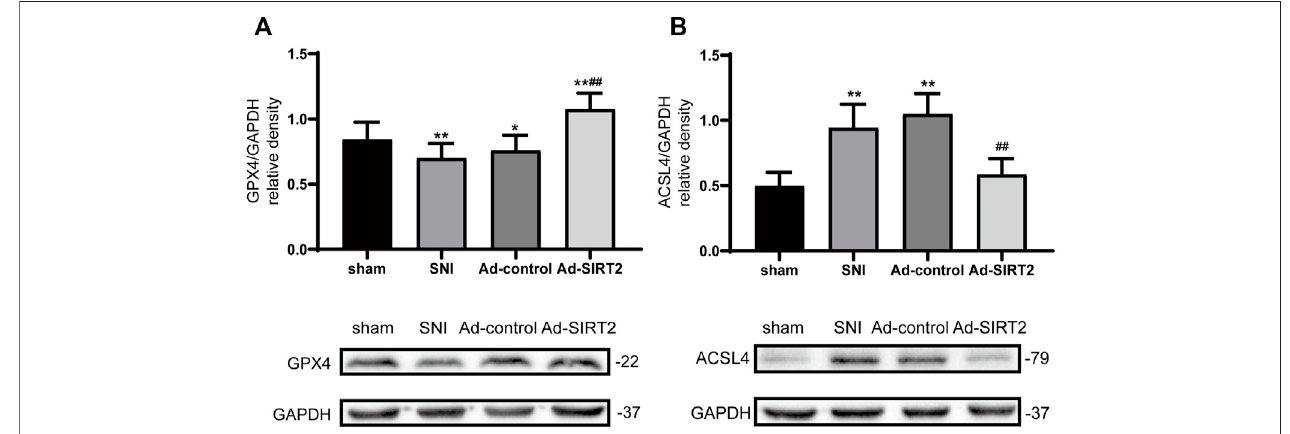
FIGURE6| IntrathecalinjectionofSIRT2increasedthelevelsofGPX4anddecreasedthelevelsofACSL4. (A) ChangestoGPX4expressioninthespinalcordafter anintrathecalinjectionofAd-SIRT2orAd-control. (B) ChangestoACSL4expressioninthespinalcordafteranintrathecalinjectionofAd-SIRT2orAd-control.Theratsin theshamoperationgroupwereusedascontrols.Valuesareexpressedasmean±SE( n =5foreachgroup).* p -valuesof < 0.05and** p -valuesof < 0.01forcomparisons withshamratsorbaselinevaluesoftheSNIrats(day0);## p -valuesof < 0.01forcomparisonswithSNIorAd-controlrats.SNI,spared nerveinjury;SIRT2,sirtuin2; GPX4, glutathione peroxidase 4; ACSL4, anti-acyl-coenzyme A synthetase long-chain family member 4.